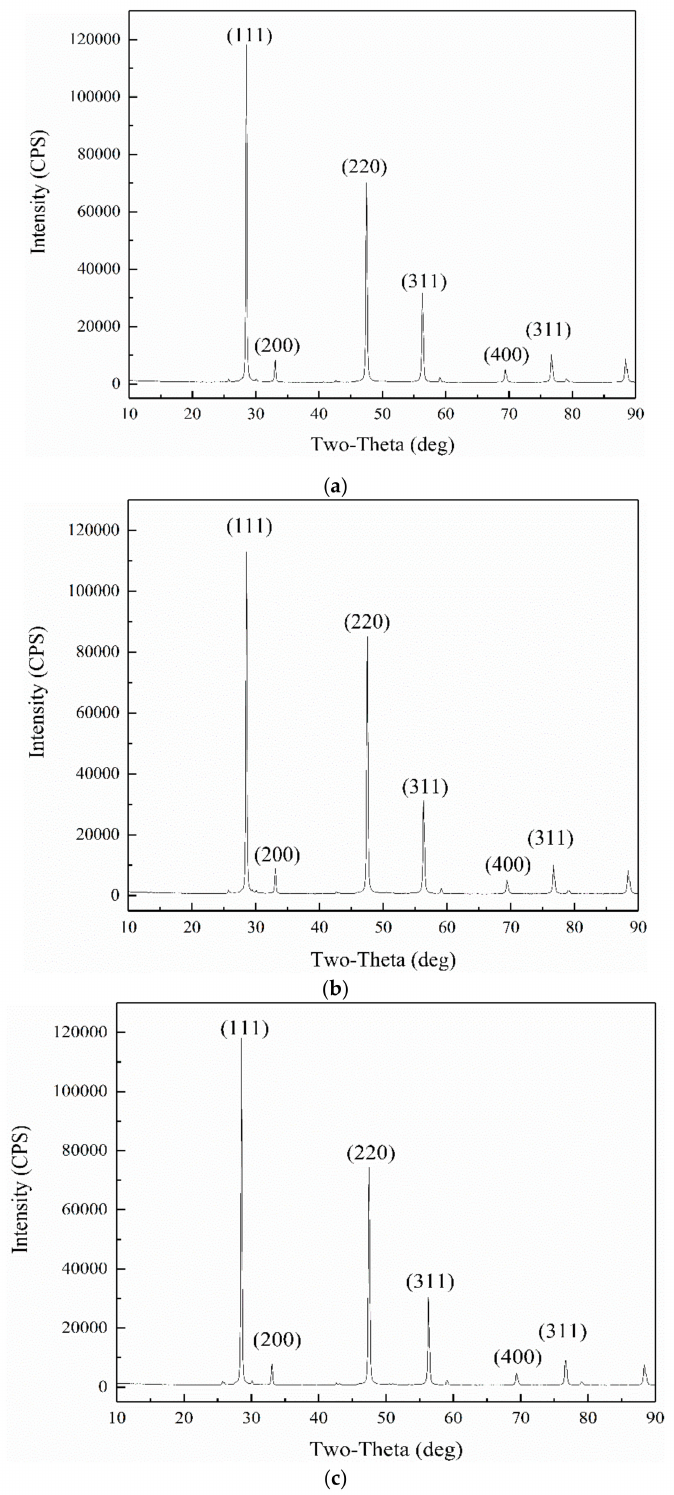
Figure 1. X-ray di ff raction patterns of the sphalerite samples: ( a ) Sample 1; ( b ) Sample 2; ( c ) Sample